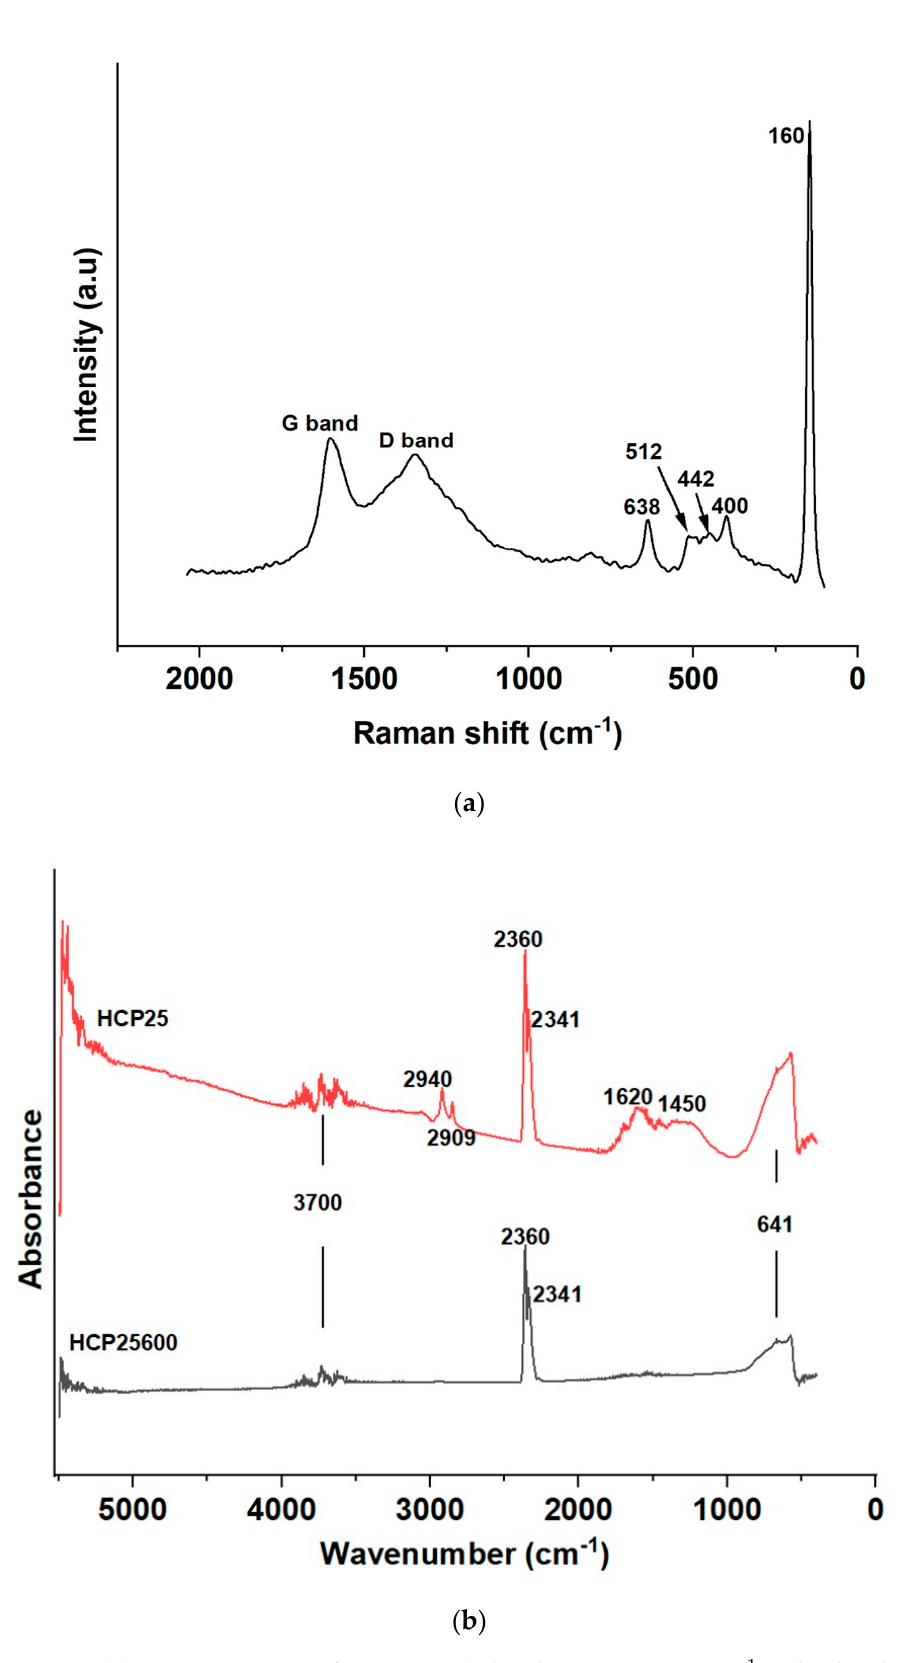
Figure 8. ( a ) Raman spectrum of HCP25600 (G band position: 1607 cm − 1 and D band position: 1352 cm − 1 ) and ( b ) FTIR-ATR spectrum of HCP25600.